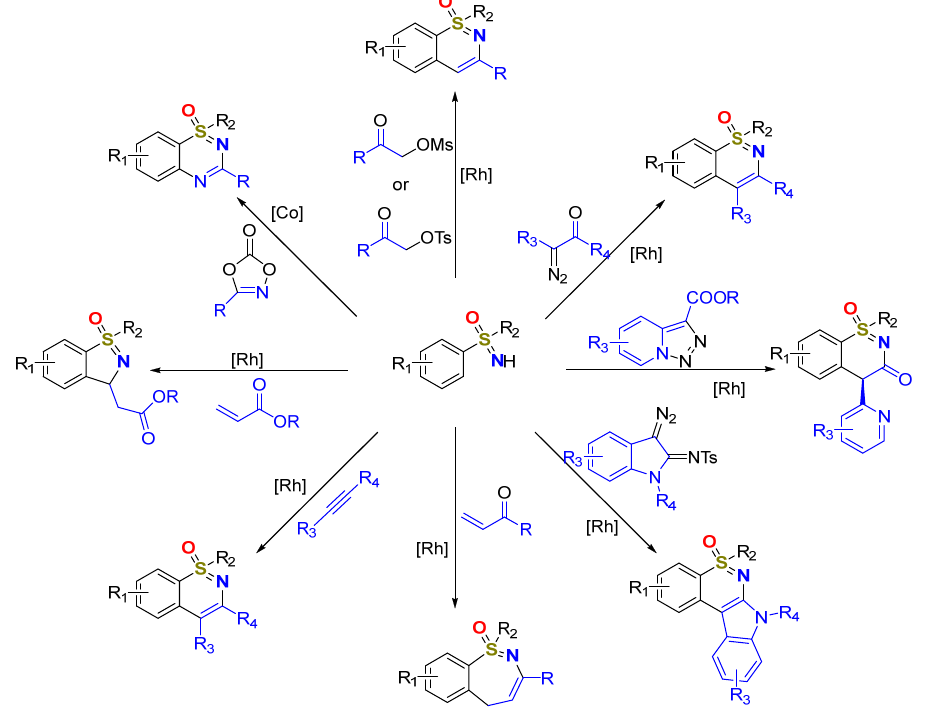
Figure 2. The main strategies towards cyclic sulfoximines synthesis.